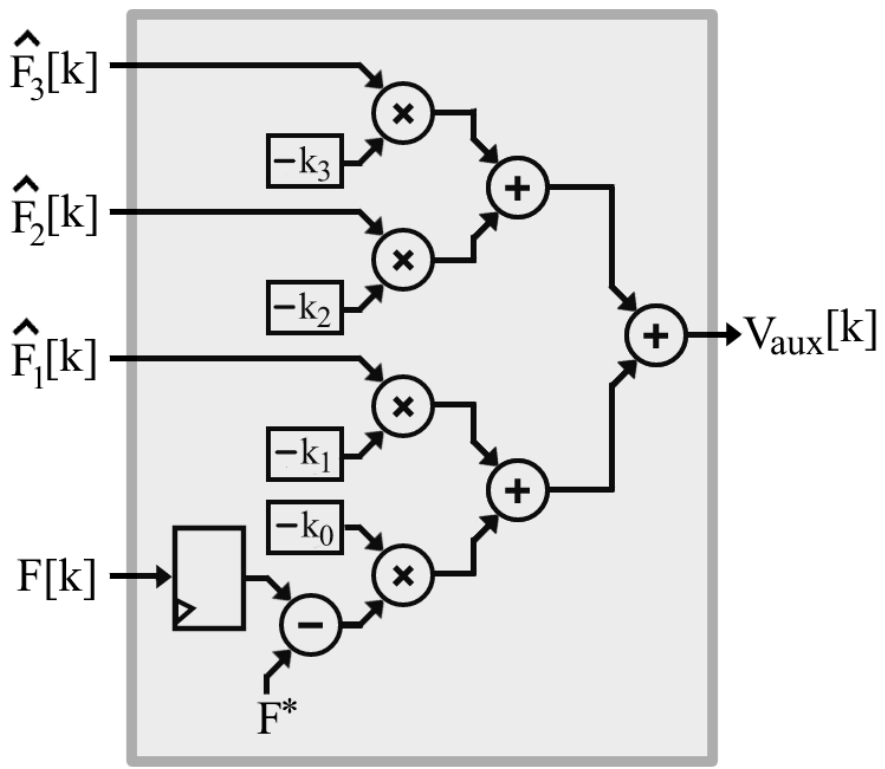
Figure 12. Implementation of the auxiliary controller module.